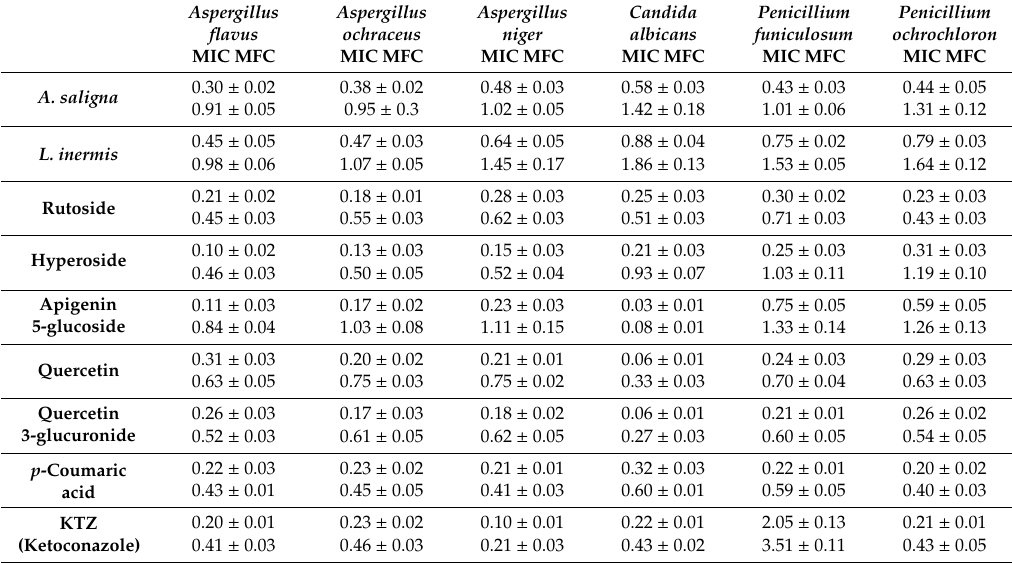
Table 3. Minimum inhibitory (MIC) and fungicidal concentration (MFC) of A. saligna and L. inermis methanolic extracts, rutoside, hyperoside, apigenin 5-glucoside, quercetin, quercetin 3-glucuronide and p -coumaric acid. Values are means of three replicates in mg / mL. Aspergillus Aspergillus ochraceus flavus MIC MIC MFC